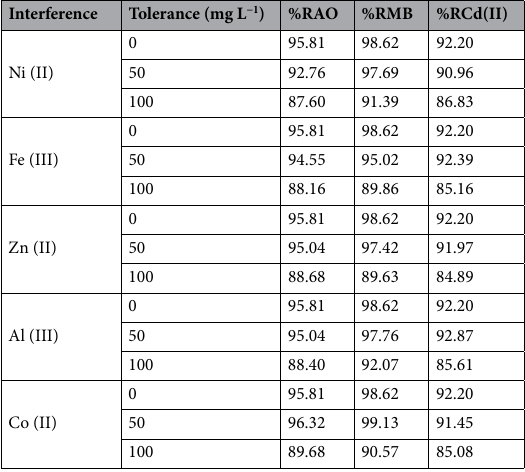
Table 6. Effect of interfering ions on the removal of AO, MB, and Cd (II).